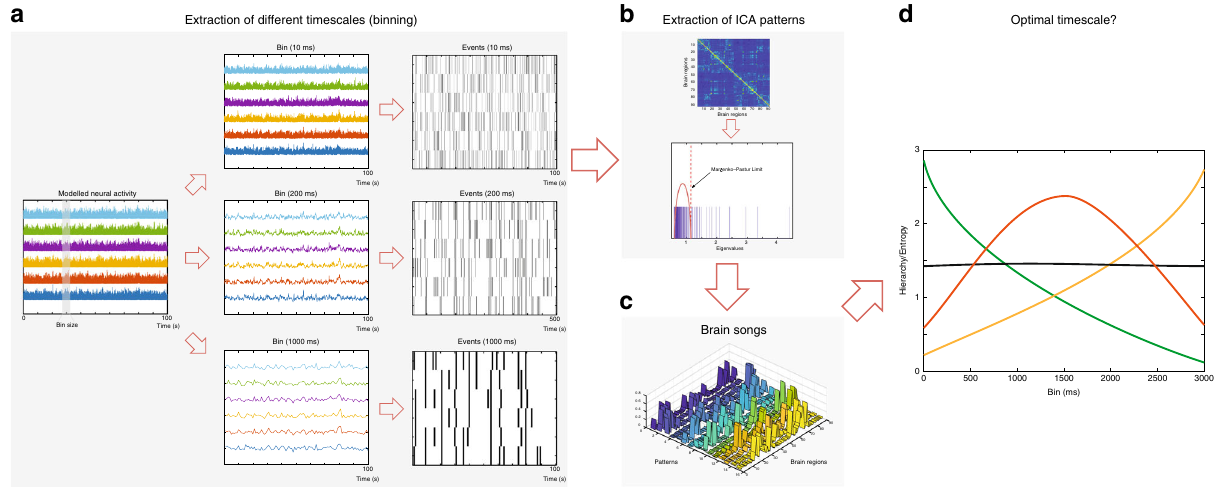
Fig. 2 Extraction of spacetime motifs. a In order to study the relevant time scale, we create different bin sizes of the milliseconds neural time series. The middle panel shows the data with 10, 200, 1000 ms bin sizes. These time binned time series are binarised using a point-process algorithm (shown on the right). b In order to extract the number of signi fi cant spacetime motifs, we compute the eigenvalues above the maximum of the eigenvalues of the null hypothesis distribution based on random matrix theory, following the Mar č enko – Pastur distribution 22 . c We then extract the spacetime motifs using independent component analysis (ICA) and estimate the corresponding activity, where co-activation patterns are found and used to track the activity over time. d The richness of the dynamical repertoire at different timescales can be computed from the spacetime motifs and corresponding probabilities allow using measures of entropy and hierarchy of functional brain organisation (see Methods). We show the four possible different scenarios of how this may vary with timescale whether fl at, monotonic decrease or increase or having an